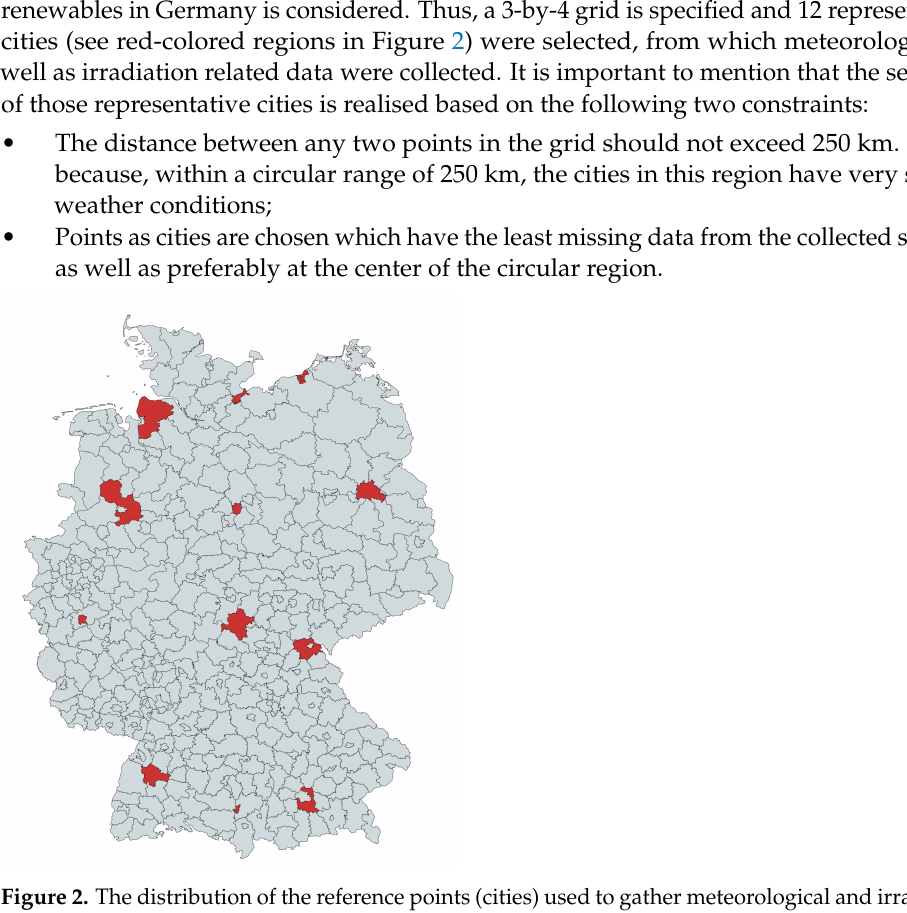
Figure 2. The distribution of the reference points (cities) used to gather meteorological and irradiation related